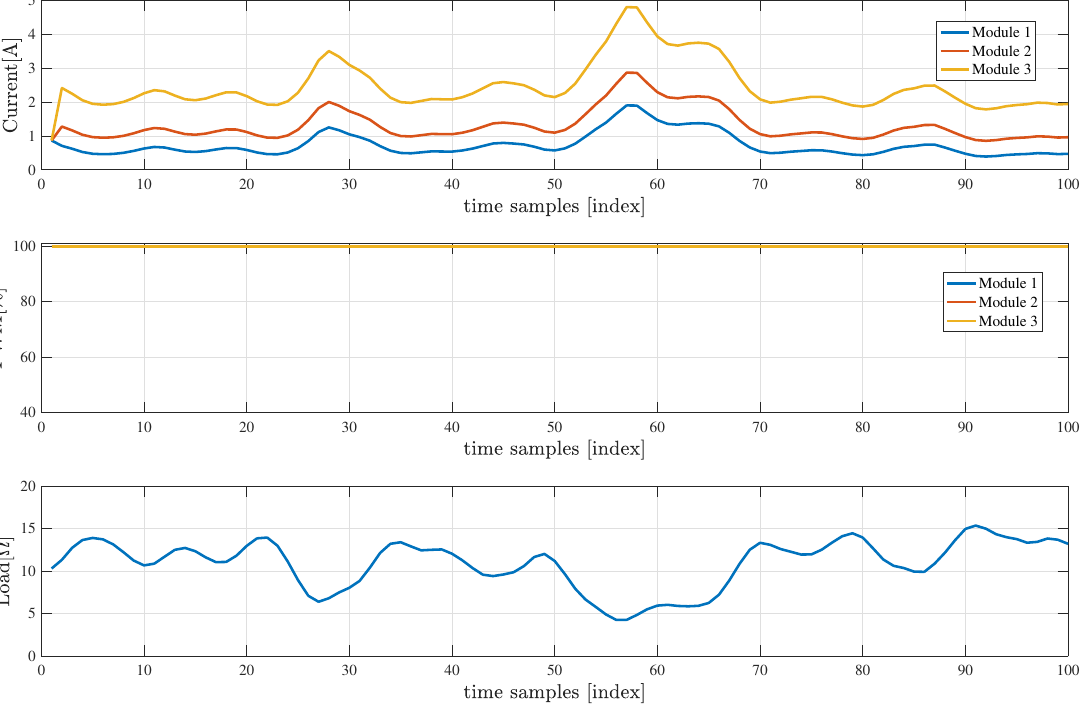
Figure 3. Currents in battery modules ( top ) and PWM modulation (all 100%) of battery voltage ( middle ) without recursive SOC balanced module scheduling of three parallel placed battery modules with accurate estimated internal impedance, subjected to a time-varying external load ( bottom